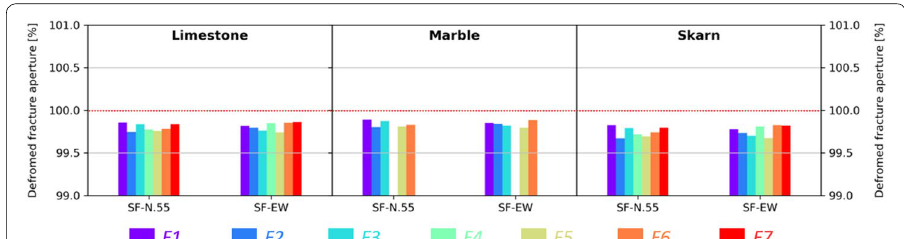
Fig. 3 Fracture aperture deformation, for each fracture set, in: the limestone formation; the marble formation; the skarn formation (The vertical scale shows the deformation as a percentage. Fractures sets F4 and F7 are not present in the marble